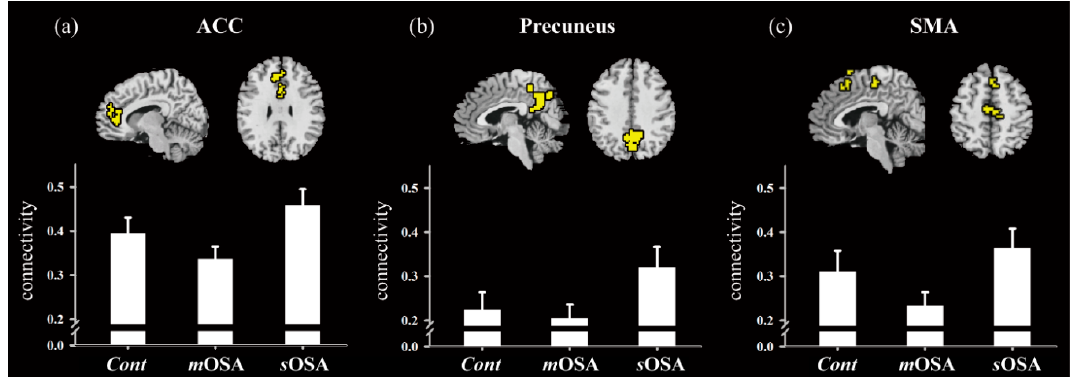
Figure 3. Functional comparison across groups for regions of the ACC ( a ), the precuneus ( b ), and the SMA ( c ). The activated regions shown in the figure were selected based on functional di ff erences between the m OSA and s OSA groups. One-way ANOVA was performed, and the p values in each full model were 0.003, 0.004, and 0.014 for the ACC, the precuneus, and the SMA, respectively. Abbreviations: Cont , Control group; m OSA, moderate OSA group; s OSA, severe OSA group; OSA,